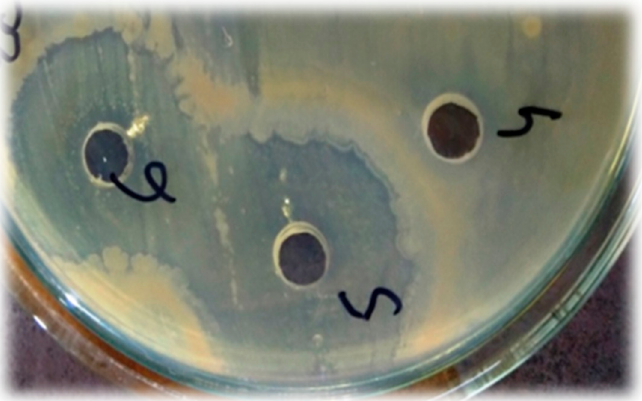
found to be significant as compared to the standard drug with p < 0.0001 in most cases.